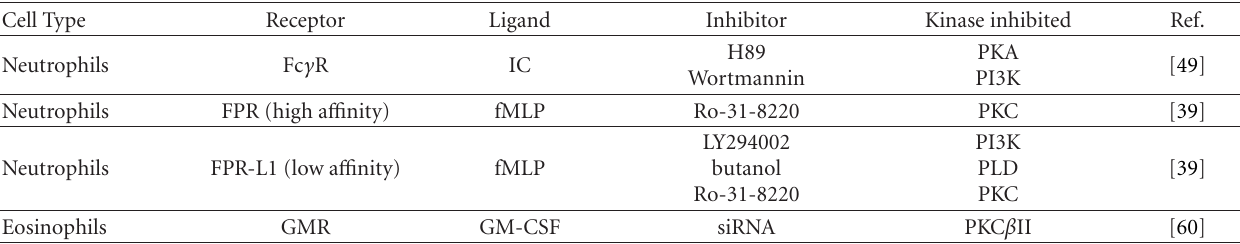
Table 1: The kinases that regulate phosphorylation of LPL in response to various cell stimuli are listed, along with the inhibitor used to test the participation of each kinase. The kinases that phosphorylate LPL in other cell types, such as T cells and macrophages, have not yet been defined. References are numbered according to appearance in the text.